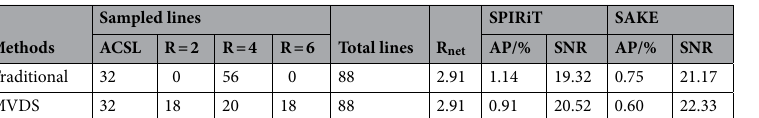
Total lines R net